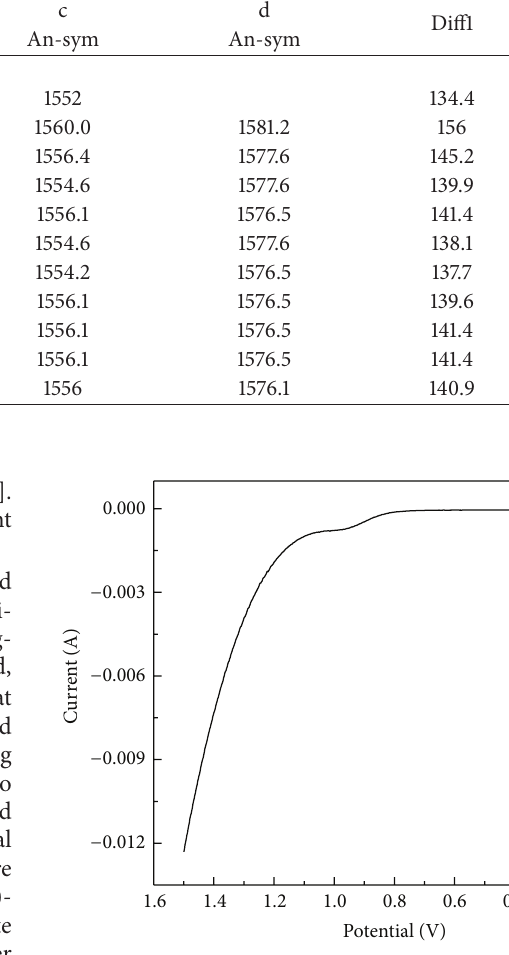
Figure4:Linearsweepvoltammetryofcerium-acetatecomplex,pH = 7.5, T = 25 ∘ C, and ] =